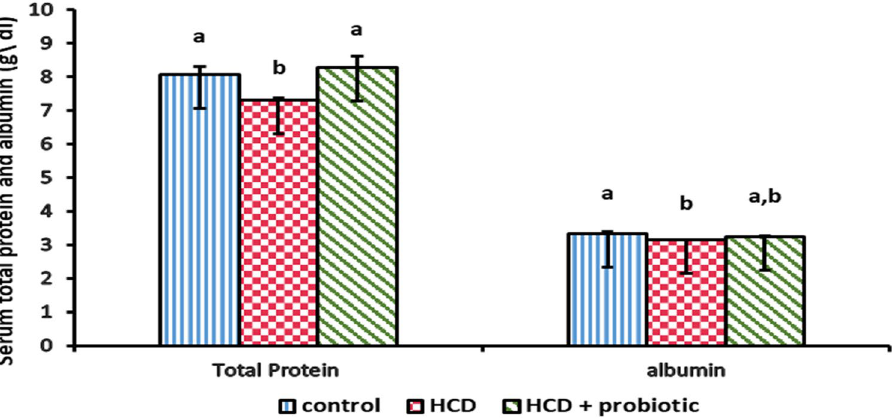
Figure 10. Effect of HCD supplementation and HCD with probiotic on liver function (Total Protein and albumin).